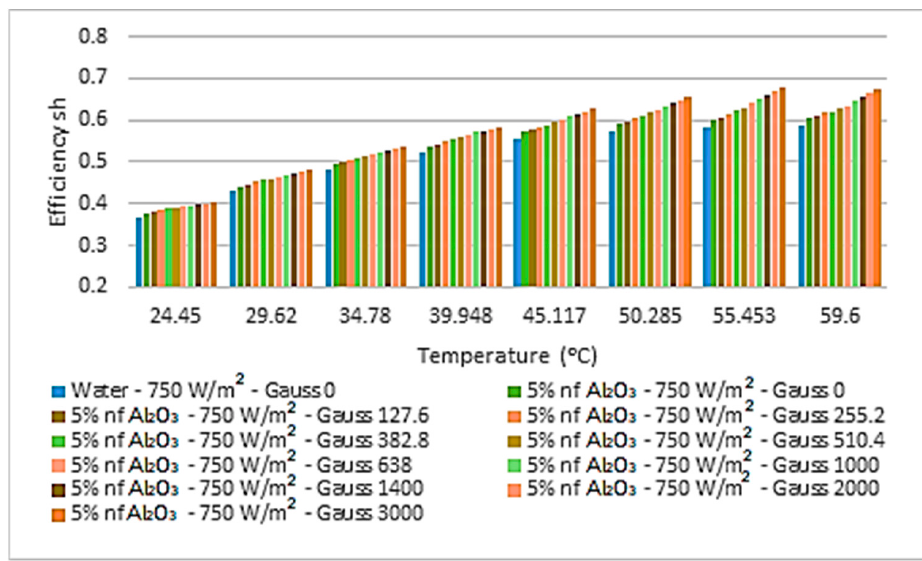
Figure 8. Thermal efficiency of hybrid system with PV-Th solar panels.